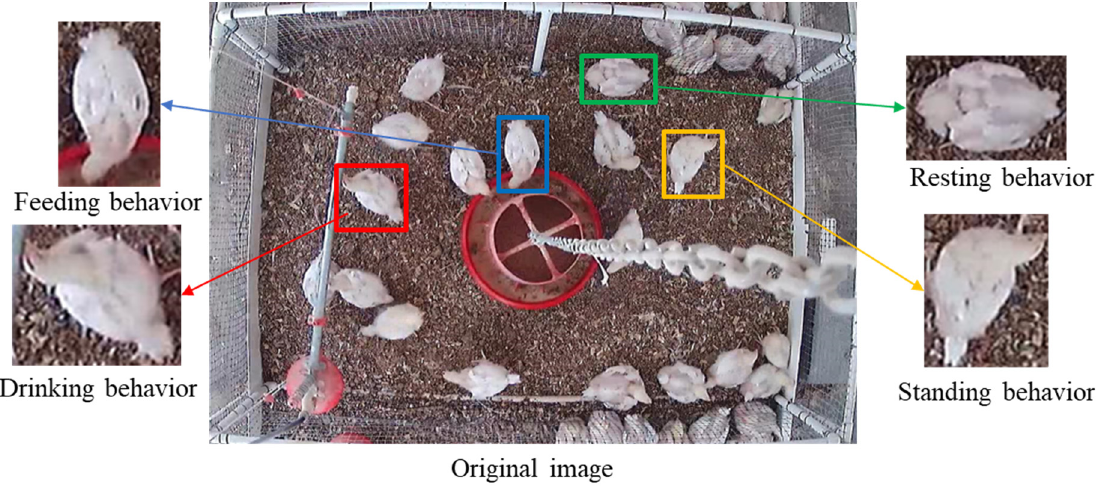
Figure 1. An example of broiler behaviors sample segmentation on d16.